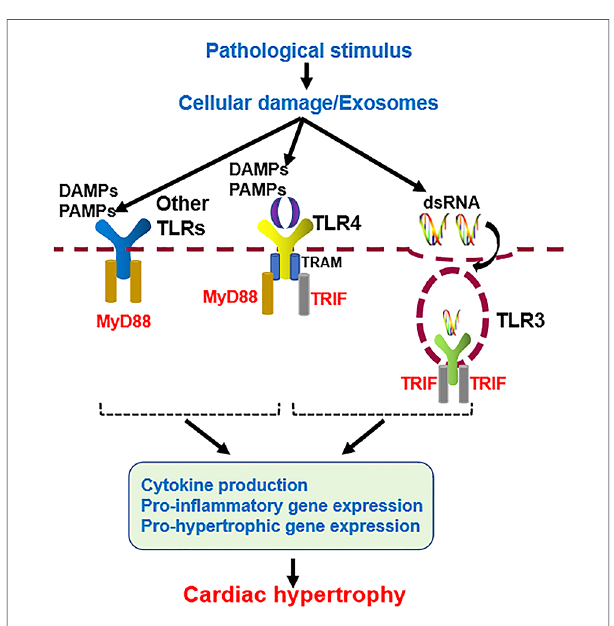
FIGURE 2 Cardiac hypertrophy mediated by MyD88-dependent and independent TLRs signaling